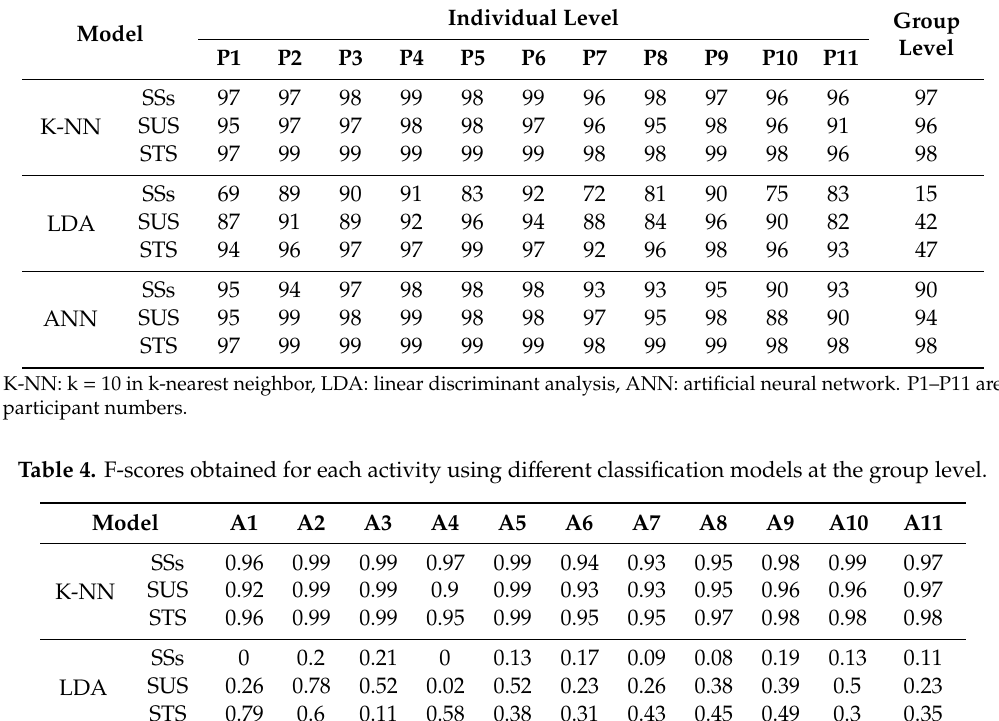
Table 3. Global accuracy (percentage) for each classification method at the individual and group levels for the smart garments (SSs), smart undershirt (SUS), and smart textile system (STS). Individual Level Group Model